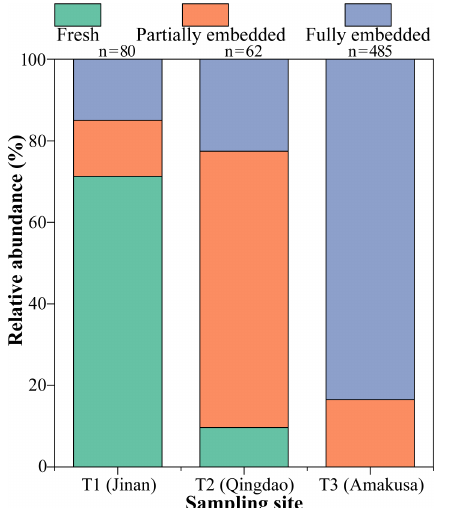
Figure 5. Fractal dimension of soot-bearing particles at the three sampling sites. The parameter n in parentheses represents the to- tal number of soot particles analyzed for each site to calculate D f and k g . Three model simulated soot particles with different D f are presented to represent different soot morphology. The inconsistency of analyzed soot number in Figs. 4 and 5 is attributed to the indis- tinct soot particles in the low-magnification TEM images that can be identified as soot but cannot provide necessary data for D f